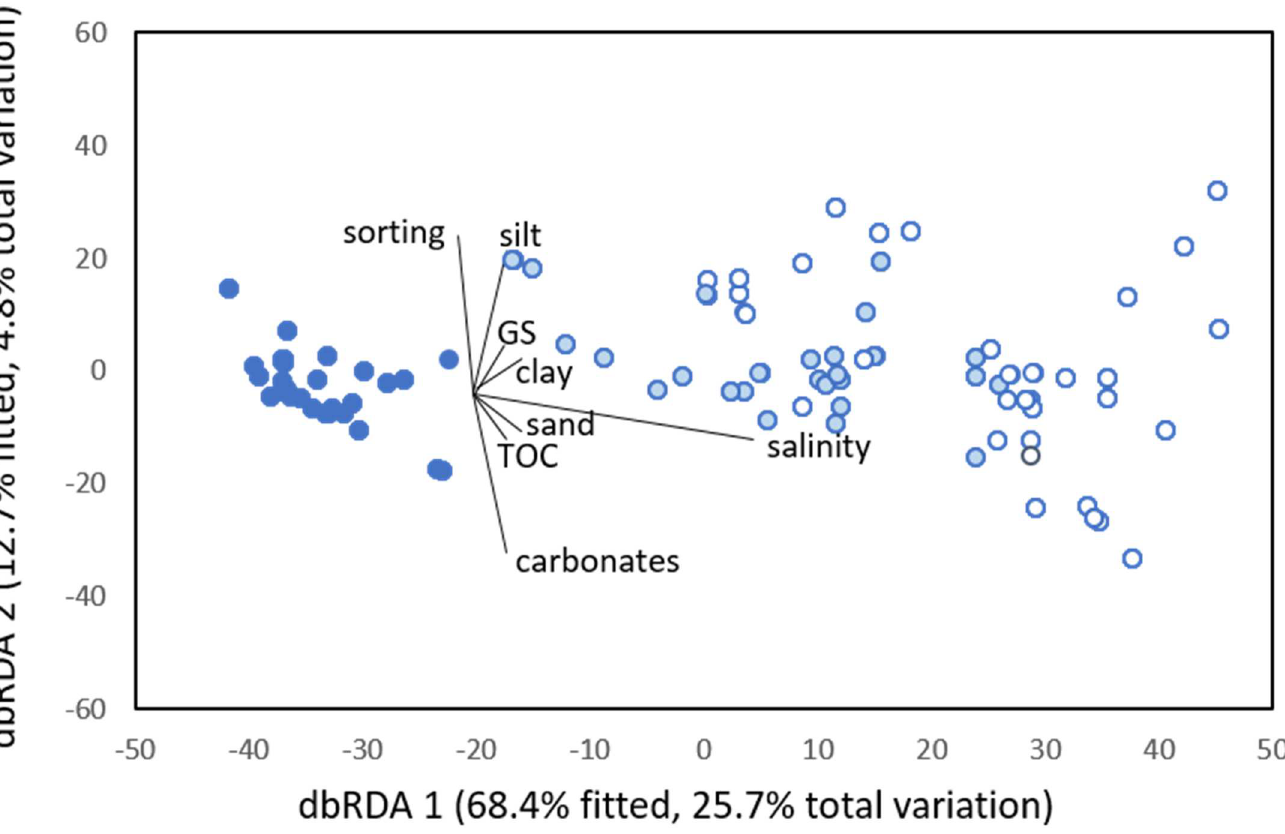
Fig 7. Distance-based RDA ordination relating environmental variables to the nematode composition. GS- grains size; TOC- total organic content; closed (dark blue circle), intermittently open/closed (light blue circle) and open (open